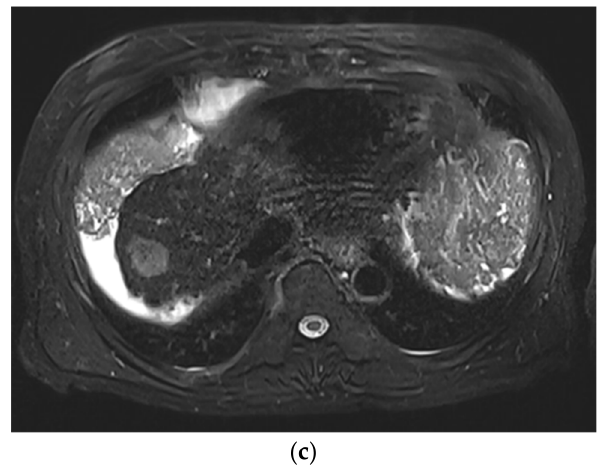
Figure 3. Comparison of conspicuity of the main liver lesion (HCC) in three T2WIs acquired on Vida. SSFSE CONV ( a ) and mTSE ( b ) were rated 3, while SSFSE CS ( c ) was rated 5. The conspicuity of pancreatic cystic lesions was rated highest for SSFSE CS (4.86 ± 0.36; median, 5; IQR, 5–5) with a significant difference between SSFSE CONV (4.00 ± 0.96; median, 4; IQR, 4–5; p = 0.008) and mTSE (2.00 ± 0.96; median, 2; IQR, 1–3; p < 0.001). mTSE was rated lowest with a significant difference compared with SSFSE CONV ( p < 0.001) (Figure 4) (Table 2). The numbers of cases with insufficient pancreatic cystic lesion conspicuity (rated 1 or 2) were two (12.5%) in SSFSE CONV , eight (50%) in mTSE, and zero in SSFSE CS .